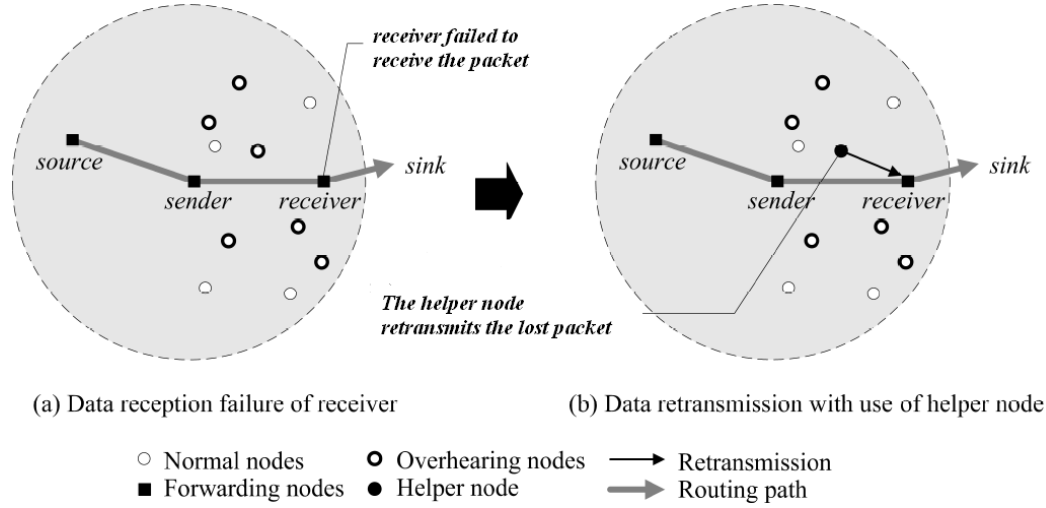
Figure 11. Retransmission process in DRDT